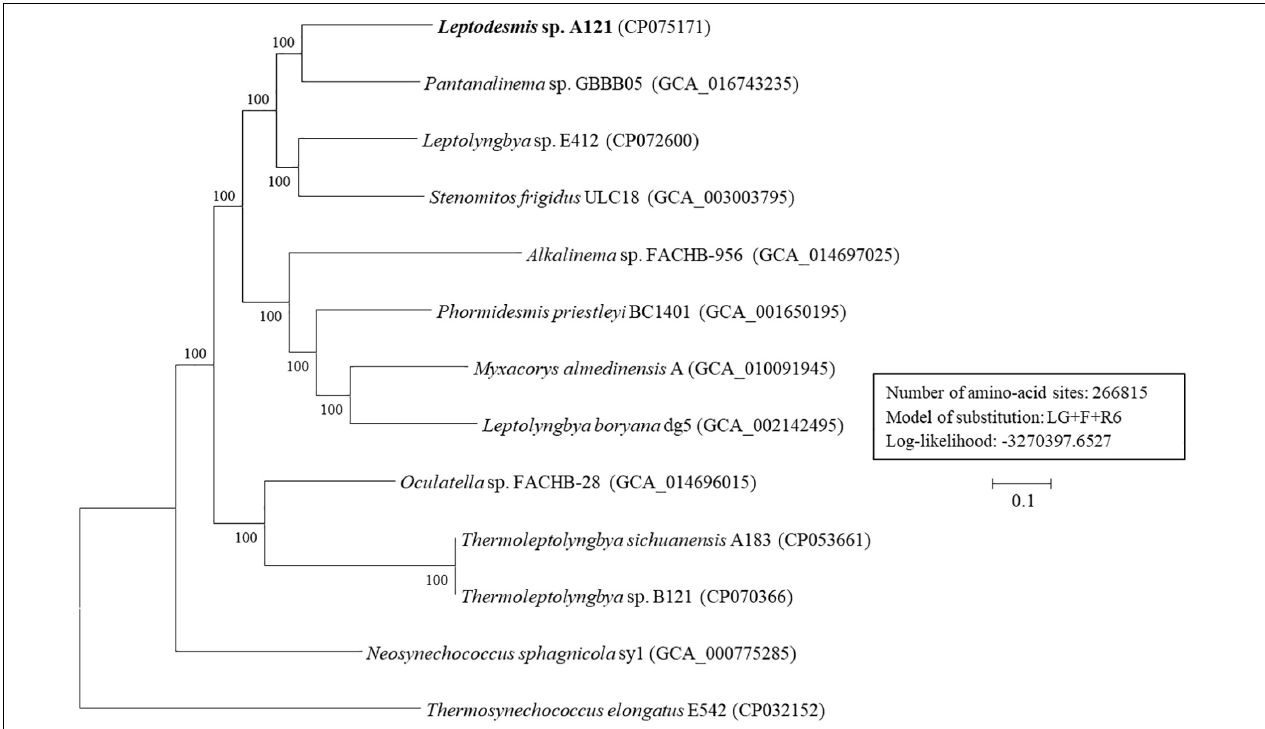
FIGURE 6 | ML phylogenomic tree of concatenated protein alignment of 845 single-copy genes shared by all genomes. Bootstrap values are indicated at nodes. Scale bar = 10% substitutions per